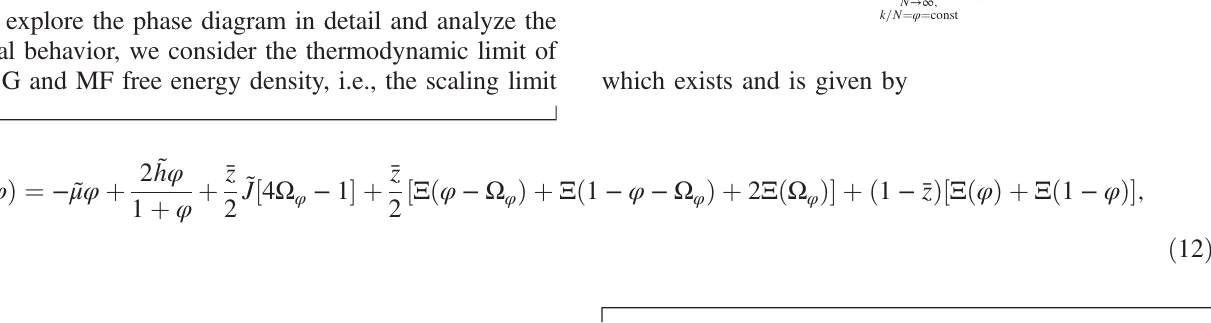
FIG. 3. Free energy landscape and equation of state for small clusters. (a) – (c) Free energy density conditioned on φ , Eq. (7) for a system of N ¼ 5 × 8 bonds on a square lattice for (a) a pushing force ˜ h ¼ 0 . 5 . Black symbols depict exact results, blue symbols the Bethe-Guggenheim approximation, and red symbols the mean field result. (d) – (f) Equation of state, h φ i , for a cluster of 5 × 8 adhesion bonds on a square lattice as a function of the dimensionless coupling ˜ h ¼ − 0 . 5 , (e) no force, and (f) a pulling force (d) a pushing force Bethe-Guggenheim approximation, and red lines are the mean field